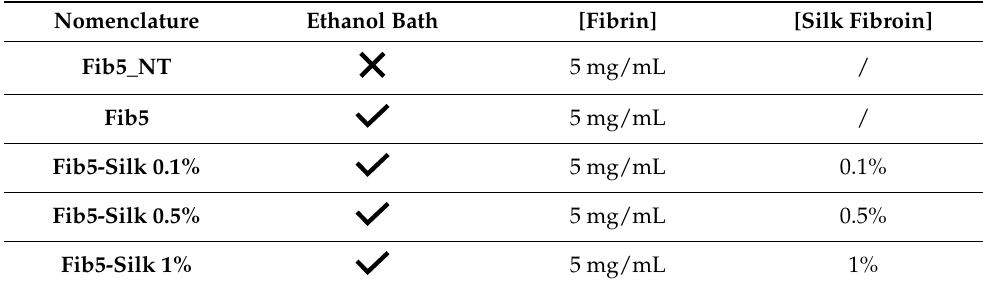
Table 1. Different conditions used for the fabrication of the scaffolds.